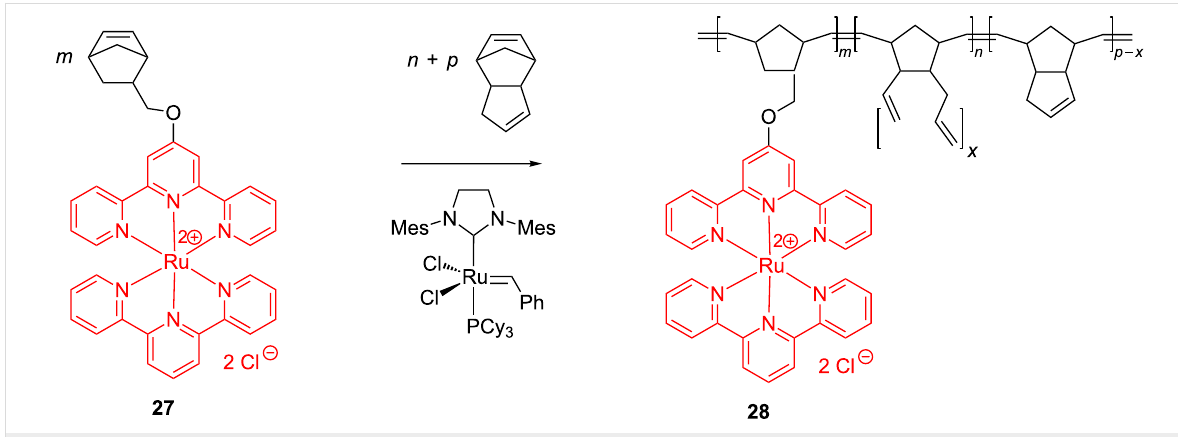
Scheme 12: Synthesis of cross-linked Ru-containing triblock copolymers.